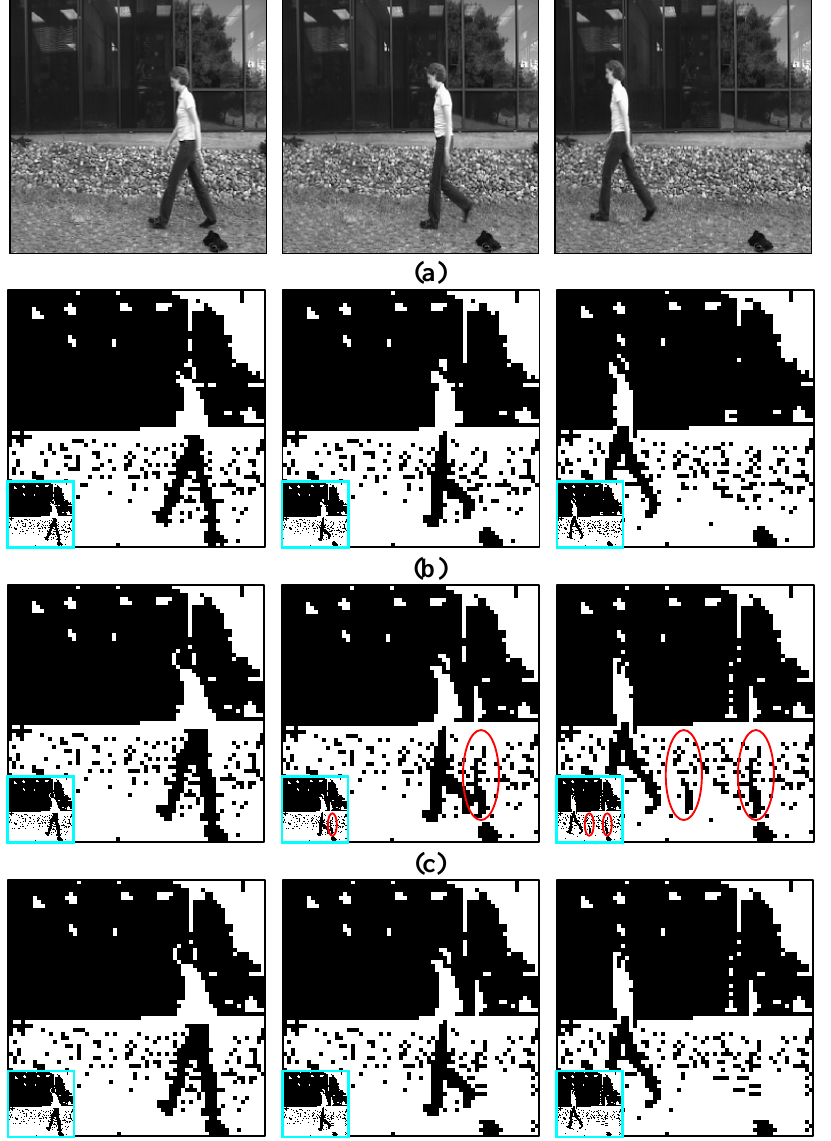
Figure 4. Illustrations for some sampled frames from walking girl video streams. (a) Top row: Original frames in the grey form with size of 256 × 256. (b) The second row: Original frames in the binary form with size of 64 × 64. (c) The third row: Motion compensated frames in the binary form with size of 64 × 64. (d) Bottom row: Shape compensated frames in the binary form with size of 64 × 64. Left column: Frame 6. Middle column: Frame 12. Right column: Frame 45. All binary images are magnified to see the details, also with the non-magnified images located in the left bottom for visual